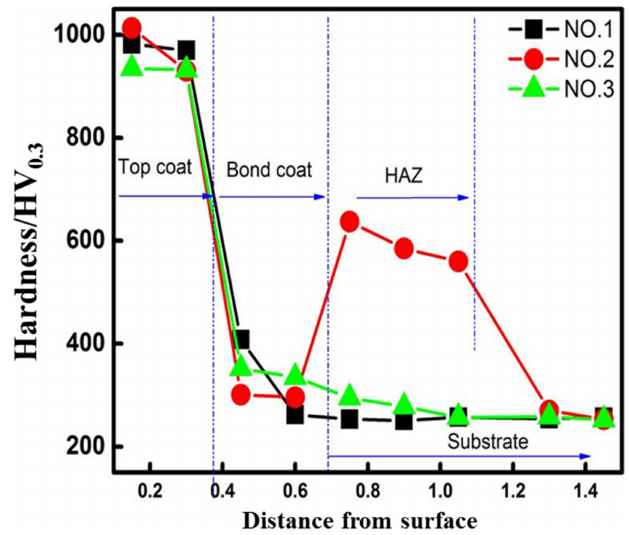
Figure 7. The hardness of samples as a function of the distance from the surface.